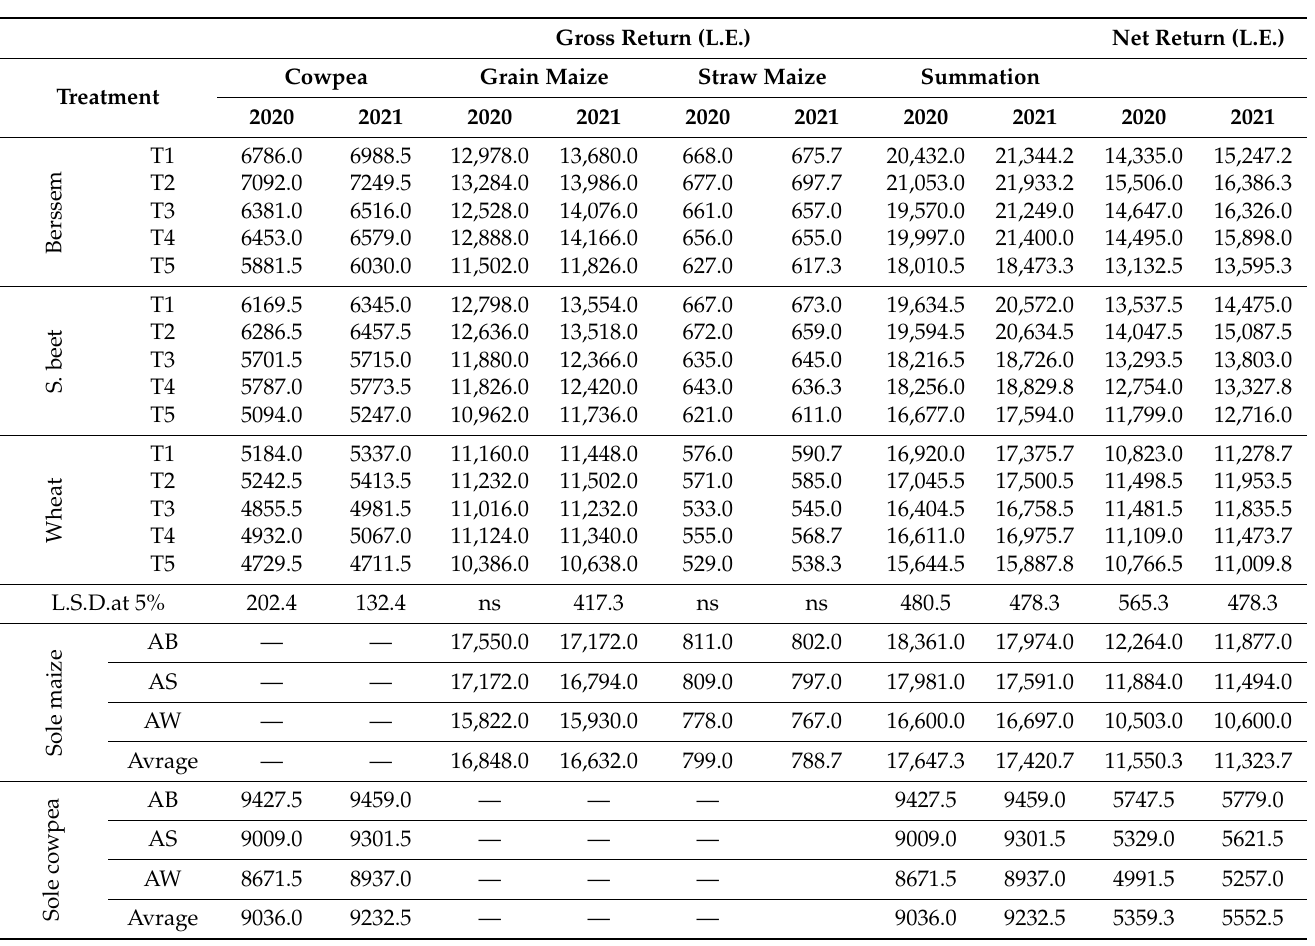
Table 10. The effect of preceding crops, fertilizations and their interaction on gross return (L.E.) and net return (L.E.) for maize intercropping with cowpea during 2020 and 2021 seasons. Gross Return (L.E.) Net Return (L.E.) Grain Maize Straw